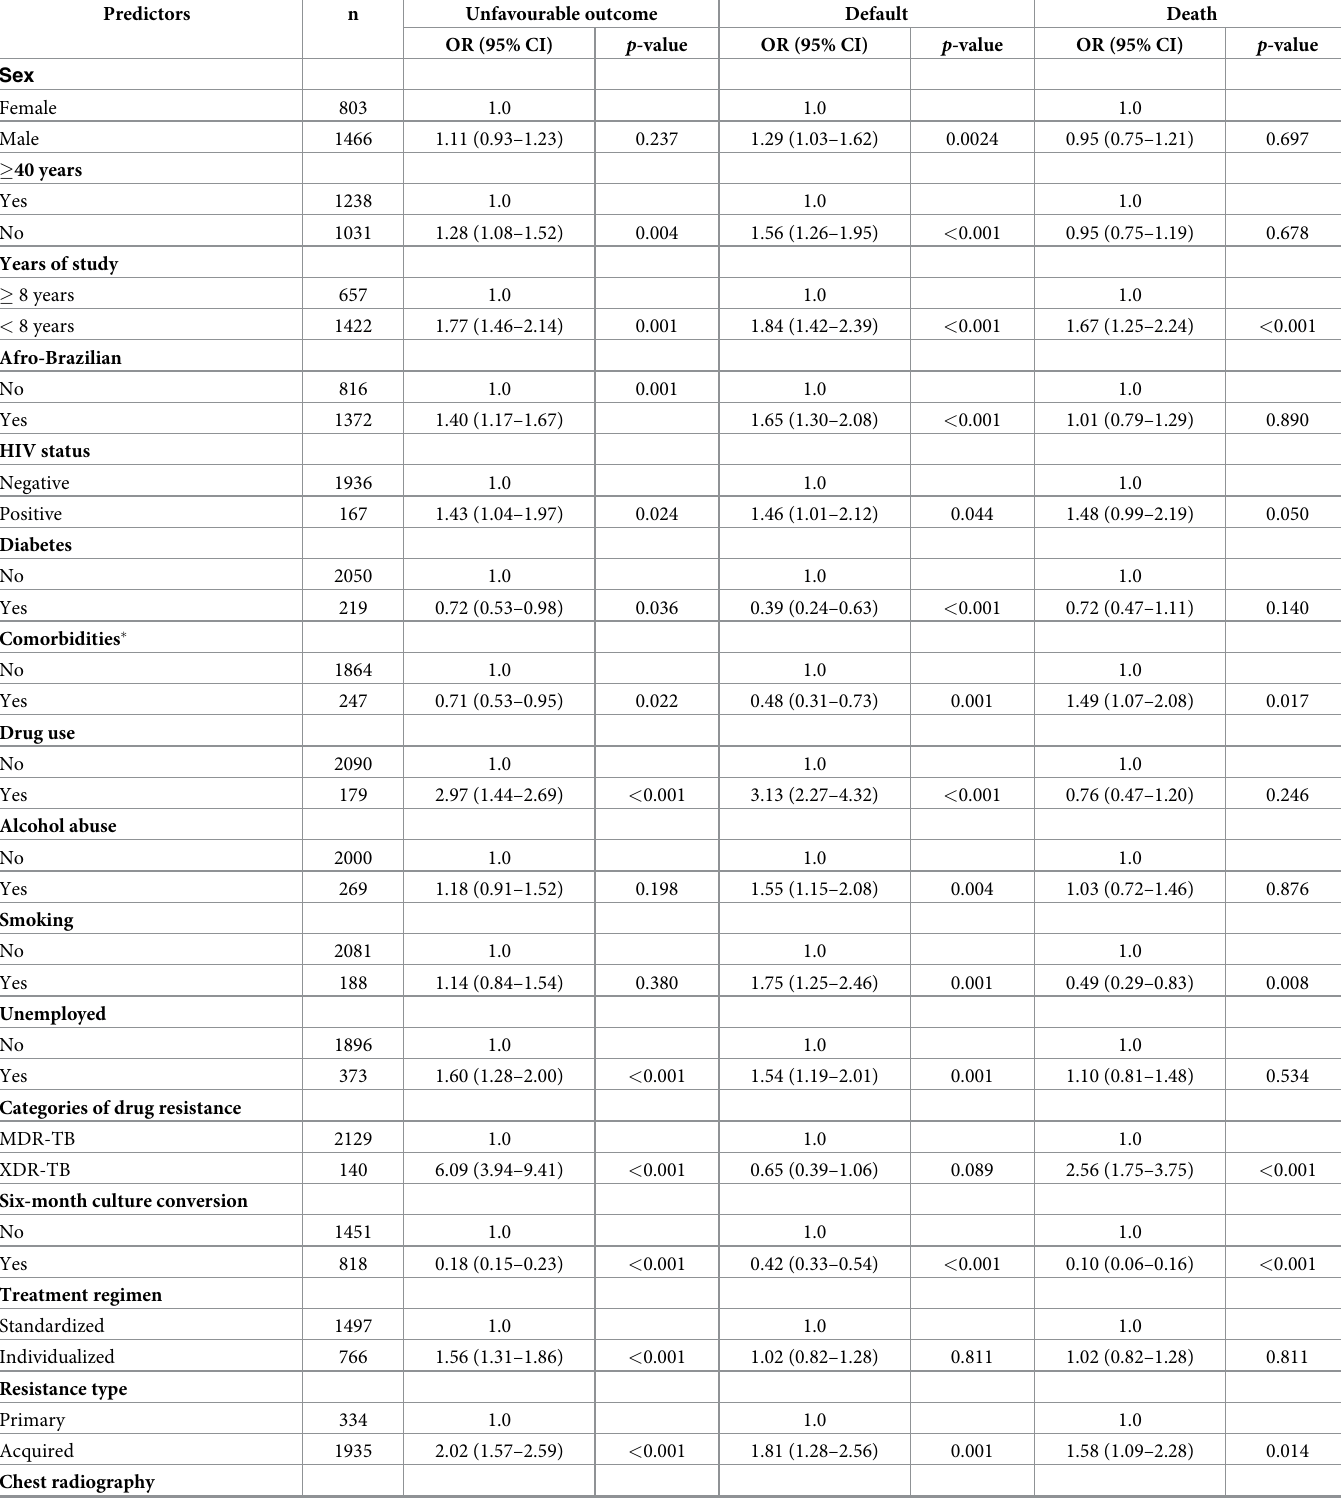
Table 4. Univariate analysis: Predictors of unfavourable outcome, default and death among 2269 patients with MDR-TB and